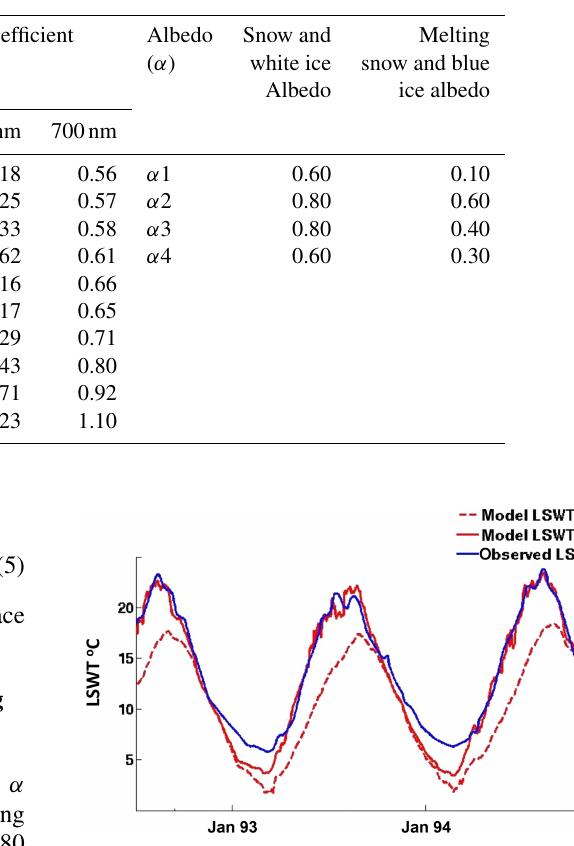
Figure 8. Lake surface water temperatures (LSWTs) for Lake Geneva, Europe (46 ◦ N 6 ◦ E), modelled with two different κ d val- ues ( κ d 2 κ d 6 ; Table 2) shows the substantially stronger effect of κ d on the maximum LSWT than the minimum